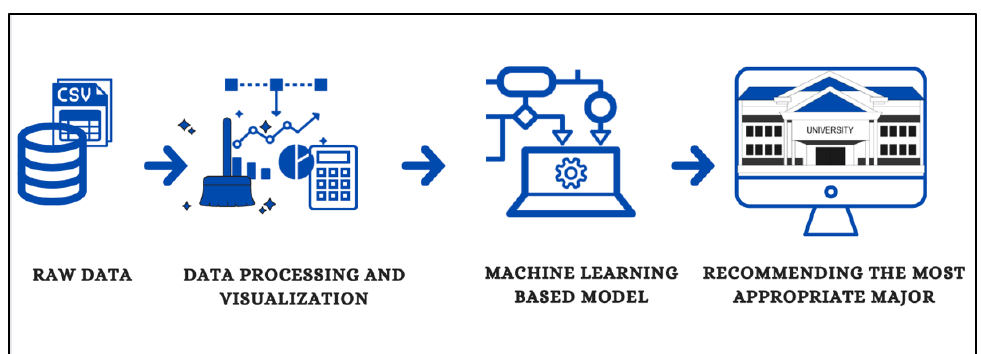
Figure 1. The workflow of a machine learning – based model for major recommendation systems at higher education institutes.